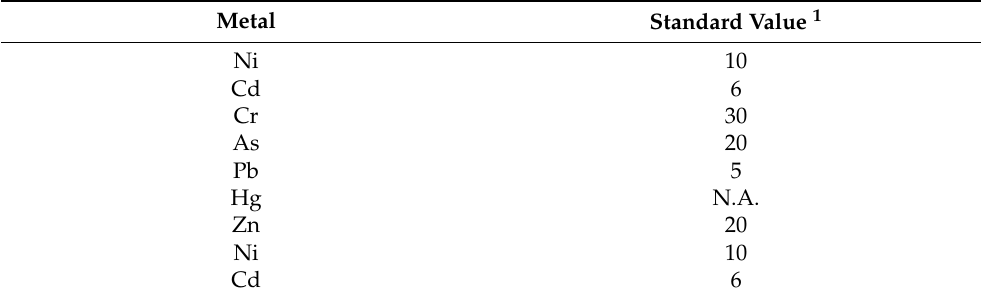
Table 1. The product quality standard value of heavy metals (mg/kg).